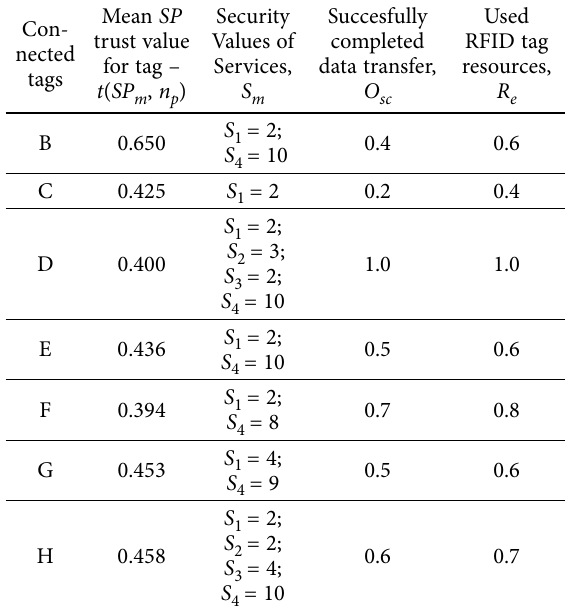
Table 5. Initial conditions for the Priority